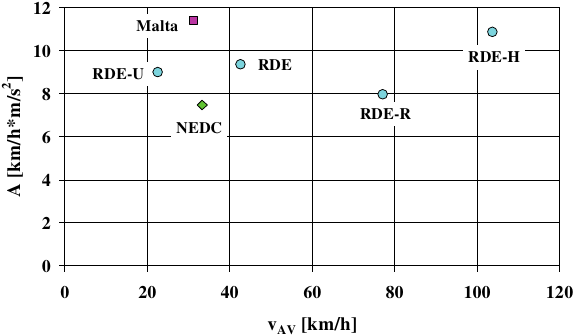
Fig. 18. The relation between the mean road emission of nitrogen oxides – b NOx and the mean vehicle speed – v AV in each test cycle